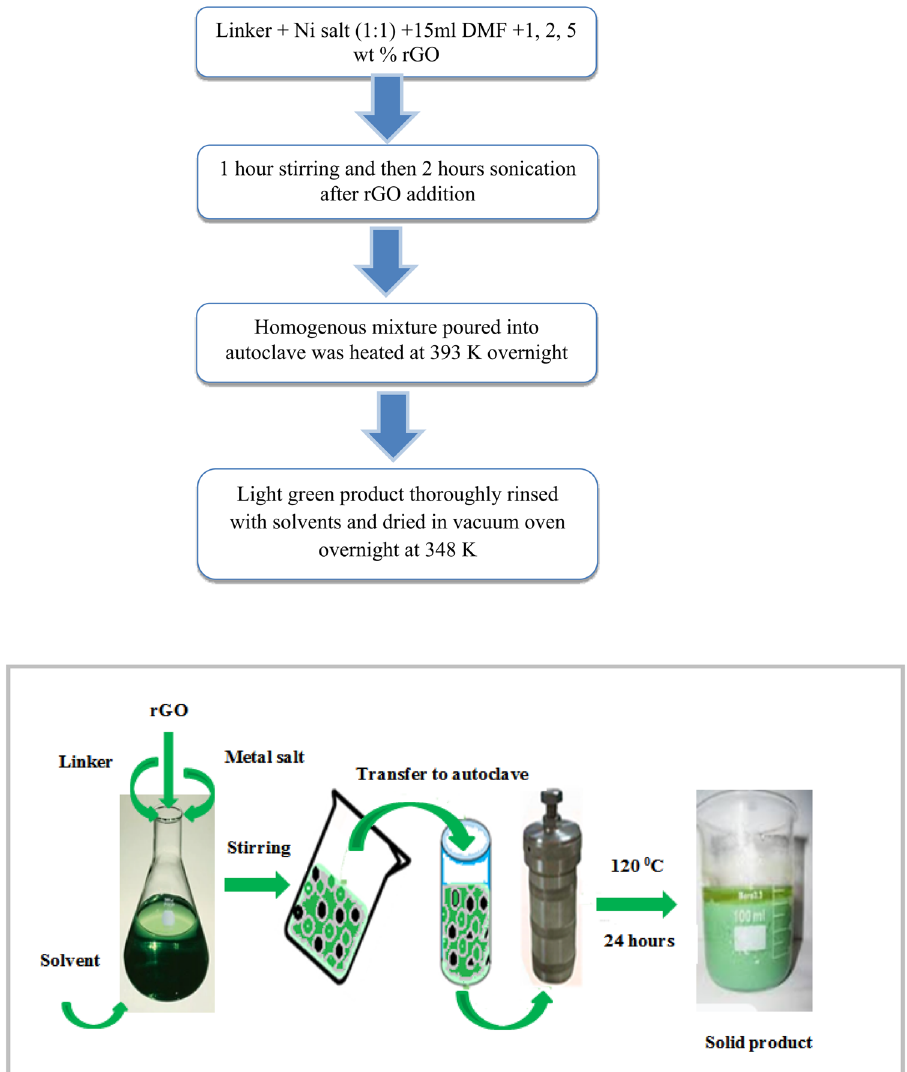
Figure 1. Stepwise synthetic scheme of NiNH 2 BDC MOF/1, 2, 5 wt% reduced graphitic carbon hybrids and flow sheet diagram for the synthesis of NiNH 2 BDC MOF/1, 2, 5 wt% reduced graphitic carbon